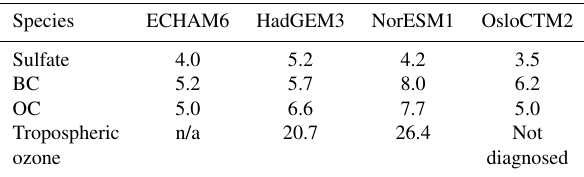
Table 5. Simulated lifetime, in days, of aerosol species and tropo- spheric ozone in the four participating